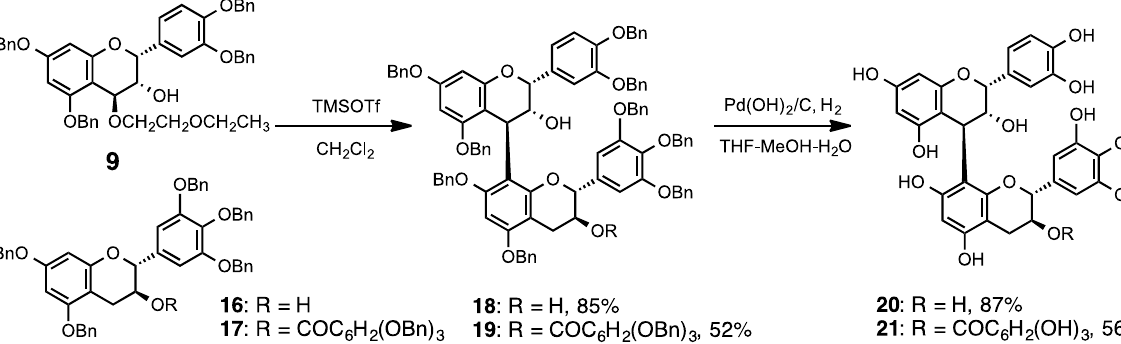
analogs against HeLa S3 cell 1